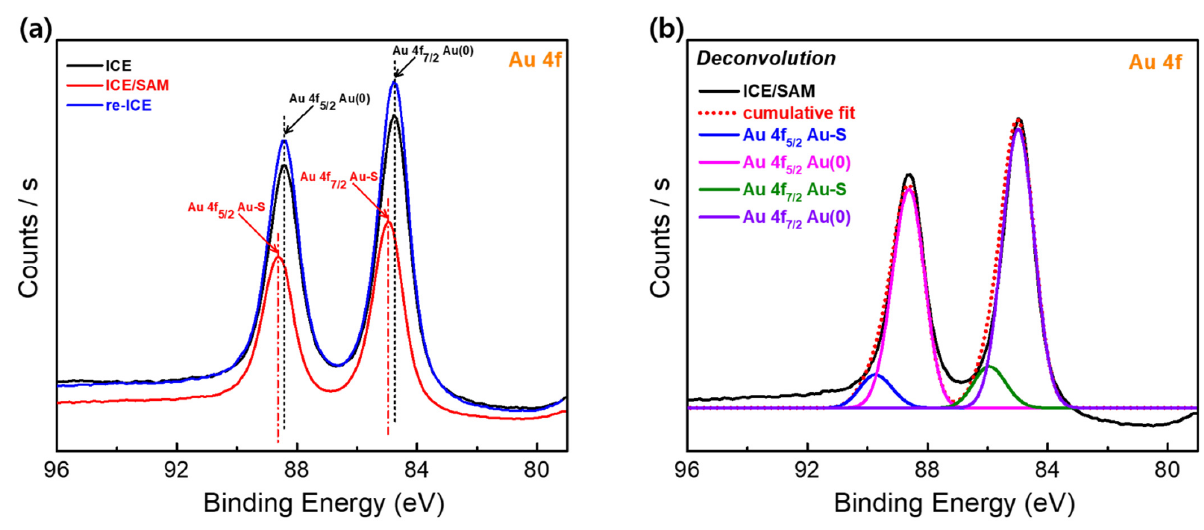
Figure 3. ( a ) XPS results of the ICE, ICE/SAM, and re-ICE. ( b ) Deconvolution of the Au 4f spectra of ICE/SAM.